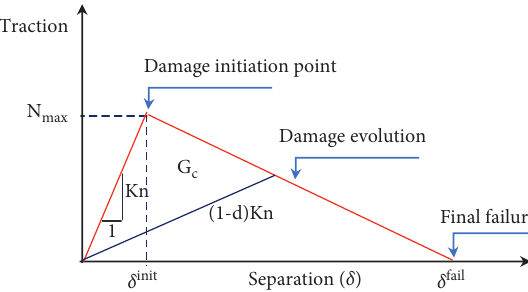
Figure 8: Traction separation model of cohesive element.